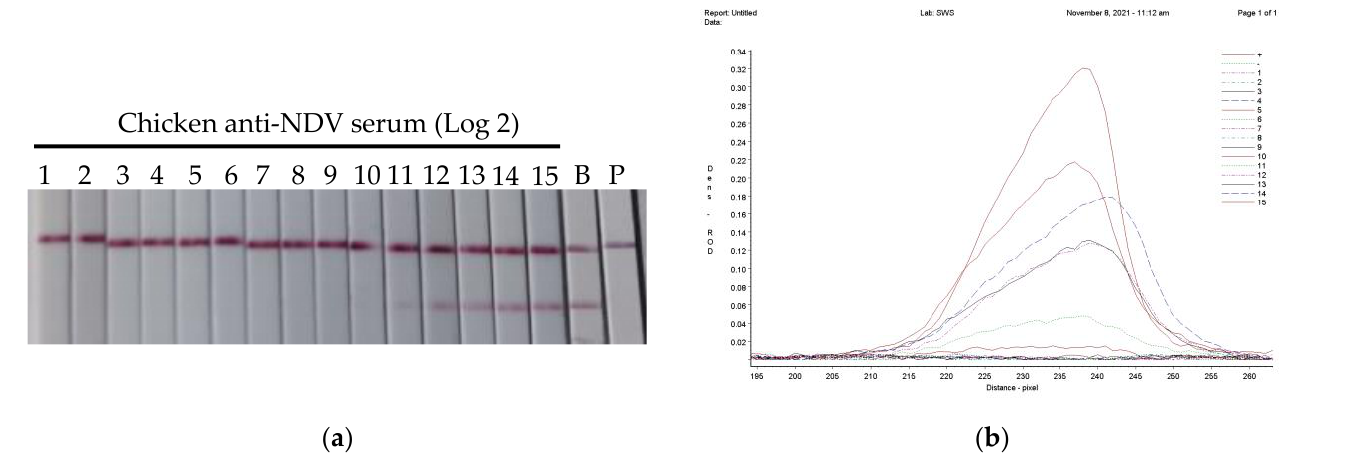
Figure 2. Determination of the bLFA strip sensitivity. The 2-fold serially diluted chicken NDV hyperimmunized serum sample was incubated with the HN protein solution for 10 min, and the mixtures were then applied to the blocking lateral flow bLFA strip and placed horizontally for 10 min to observe the result ( a ), and the colored membranes were screened by a TSR-3000 Reader, and the relative optical density (ROD) values of T-lines were analyzed by AIS software ( b ). Note: B: blank control is a strip containing protein and no serum samples; P: PBS control is a strip only containing phosphate-buffered saline. Table 3. Sensitivity of the bLFA strip compared with HI and VN tests.